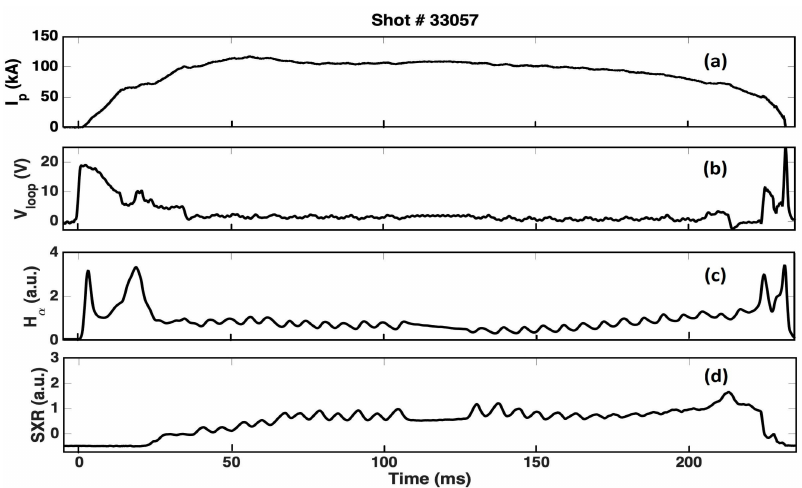
Figure 4. Time evolution of Aditya-U discharge for shot # 33057. ( a ) Plasma current (I p in kA), ( b ) loop